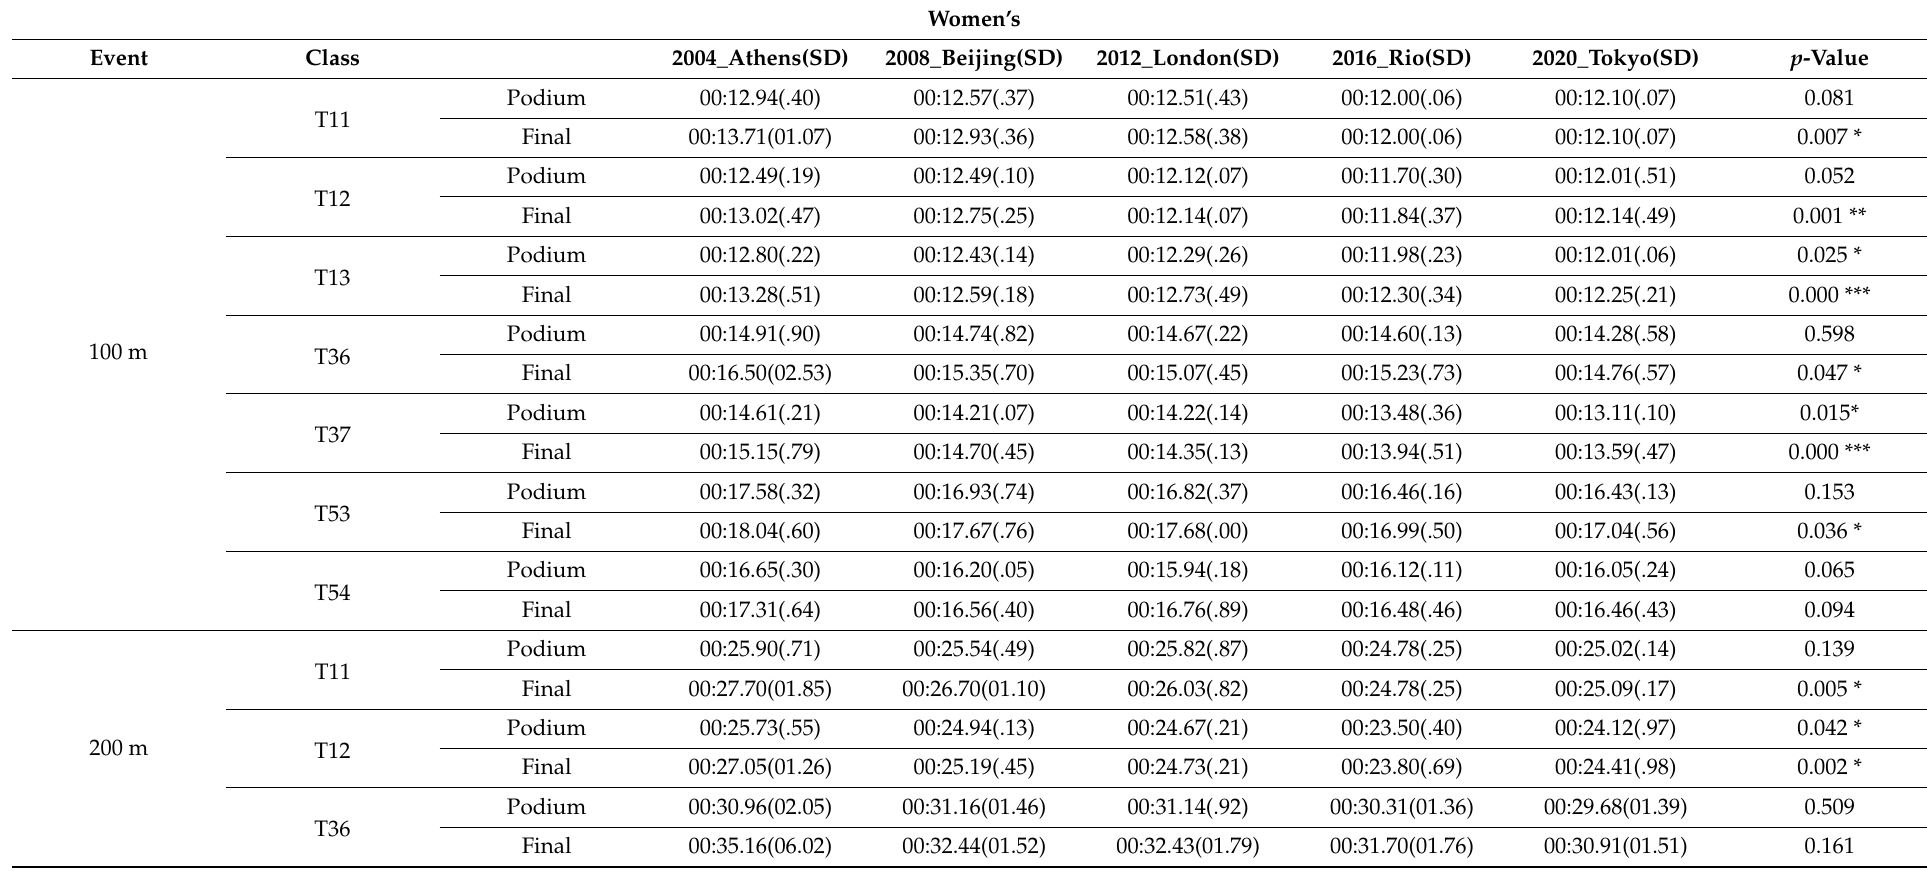
Table 4. Changes in Women’s Division Track Disciplines in the Paralympic Games (sec).